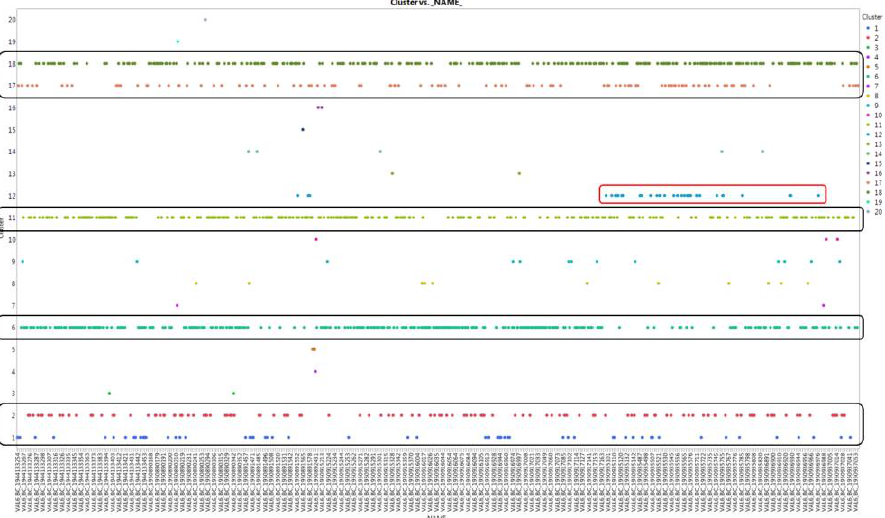
Figure 6. Box plot from the clusters of platen temperature and shaping pressure. To find more specific causes, we sought where cluster No. 12 of shaping pressure was derived from the 30 vulcanizers. We also made box plots by crossing existing clusters by each vulcanizer, as